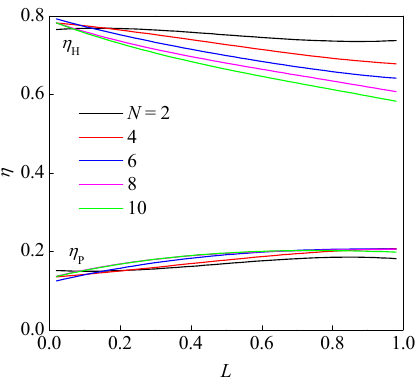
Figure 7. Results of the two efficiencies η for varied gap L and mirror number N in configuration 2.